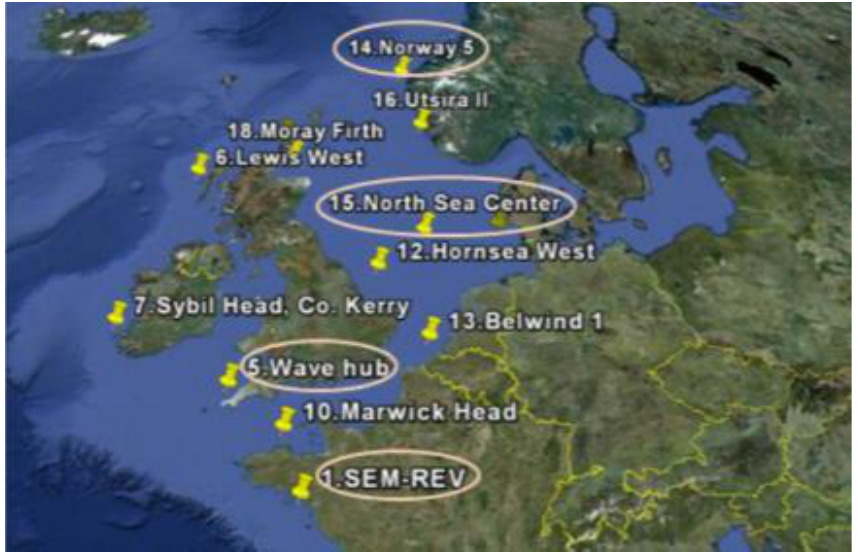
Figure 14. Location of the Norway 5 site [19]. Reprinted/adapted with permission from Ref. [19]. 2014, 20.19. Wang, Q.